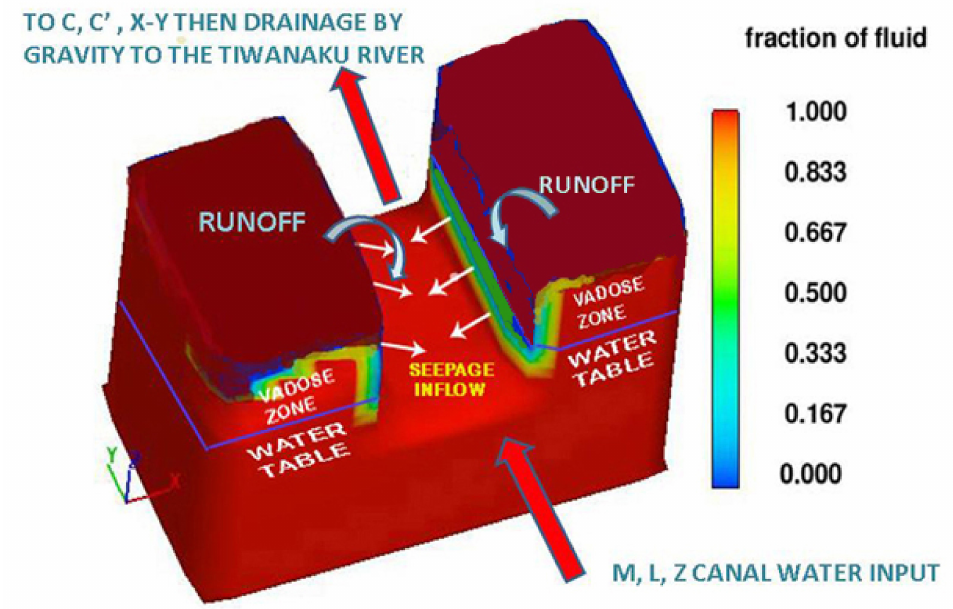
Figure 11. Summary fluid fraction diagram on water input / output flows on a typical perimeter drainage channel section near Figure 1a, and represent typical flow conditions near the end of the rainy season.